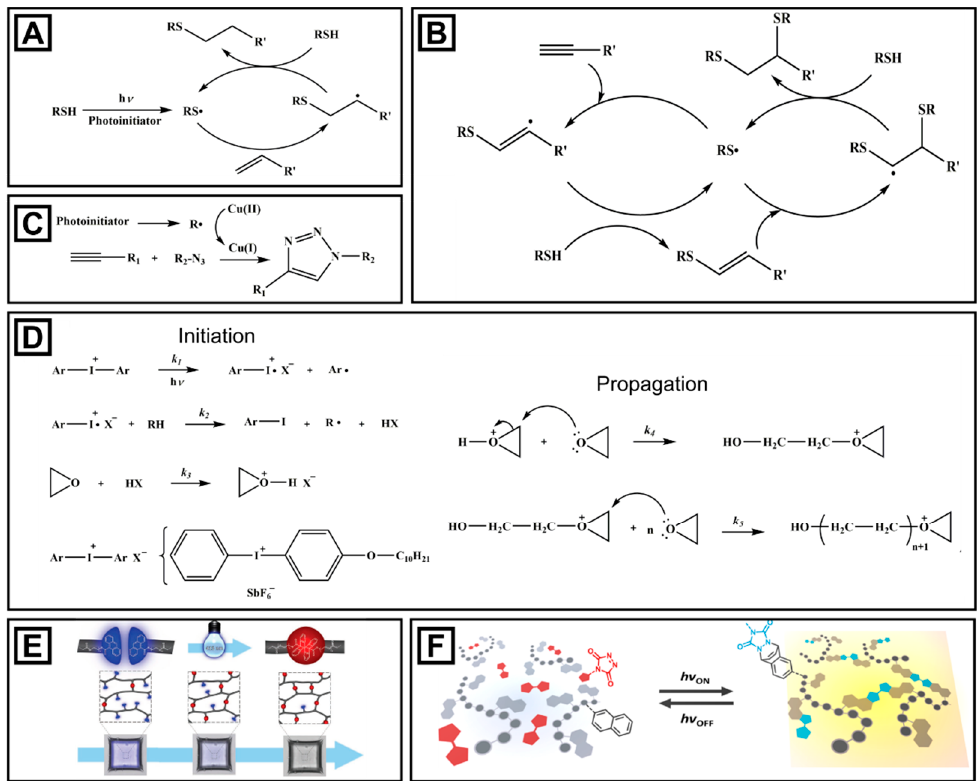
Figure 3. Potential crosslinking mechanisms in 3D printing: ( A ) thiol–ene (adapted with permission from Konuray et al. [123]), ( B ) thiol–yne (adapted with permission from Konuray et al. [123]), ( C ) copper-catalyzed azide–alkyne reaction (adapted with permission from Konuray et al. [123]), ( D ) cationic photopolymerization of epoxy monomers (adapted with permission from Crivello et al. [124]), and ( E ) cycloaddition dimerization of anthracene moieties (adapted with permission from Gernhard et al. [125]). ( F ) Schematic of covalent crosslinking of naphthalene containing PMMA polymers with bifunctional triazolinedione cross-linker in PµSL by visible-light-driven cycloaddition (adapted with permission from Houck et al. [126]).